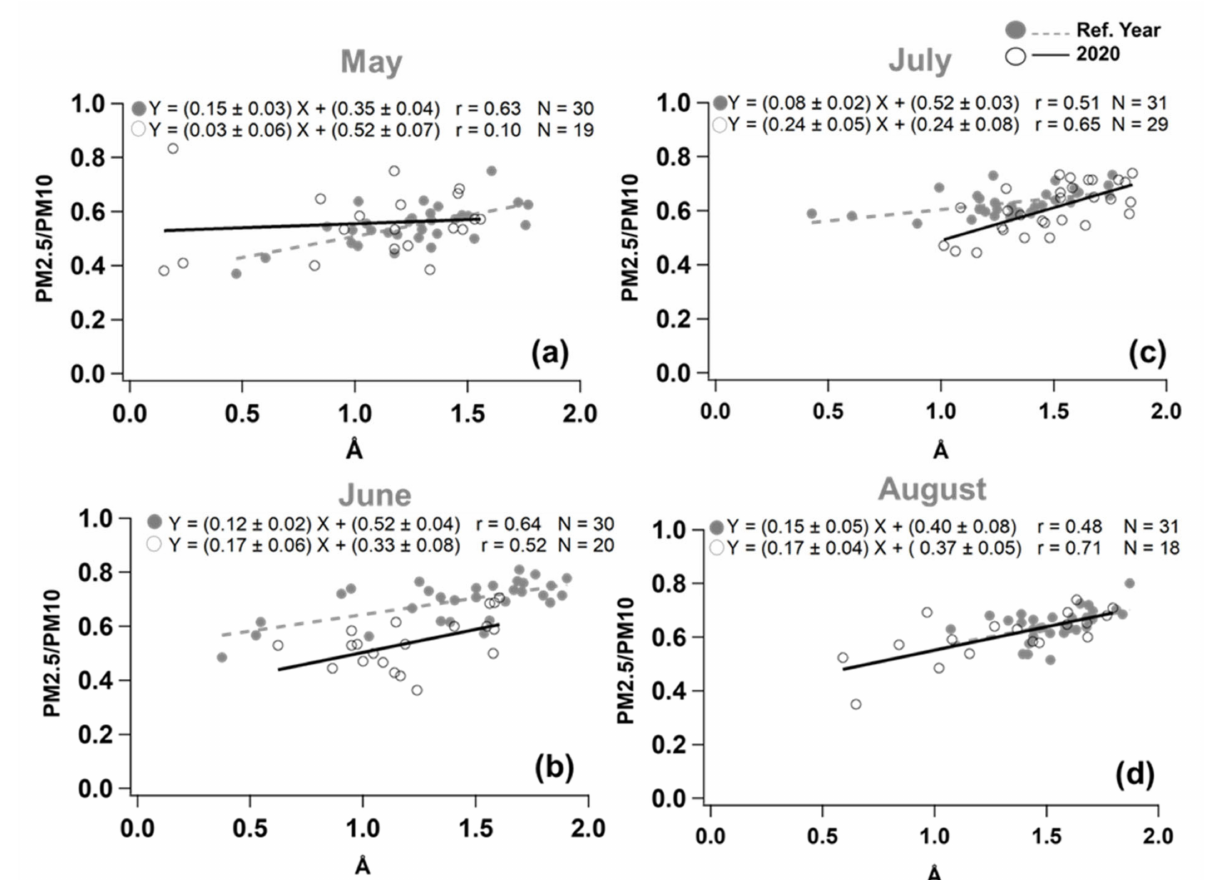
Figure 8. Scatterplot of PM2.5/PM10 mass ratio as a function of Å (Ångström exponent at the wavelength pair 440–870 nm) in ( a ) May, ( b ) June, ( c ) July, and ( d ) August for Site 4 (Lecce—Libertini). Full dots and circles represent data from the reference year (average of the years 2017, 2018, and 2019) and the year 2020, respectively. Fitting regression line equations, Pearson correlation coefficient (r), and the number of points (N) are also